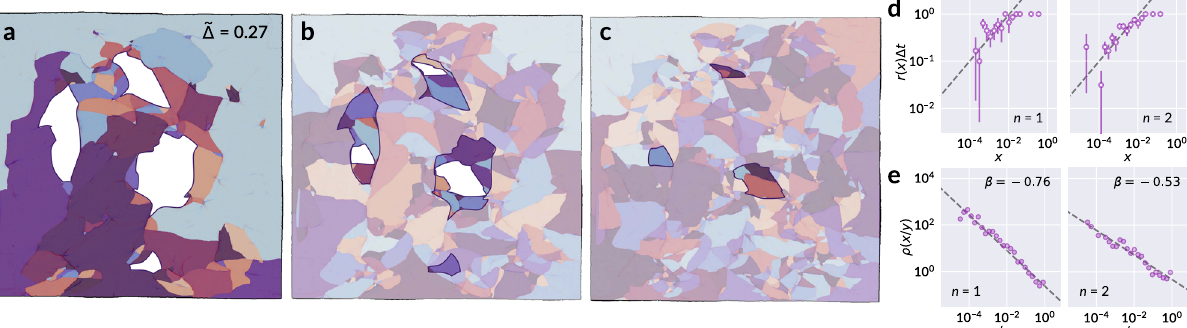
Fig. 2 Estimation of breakup rates. a Segmentation of a sample sheet crumpled once at compaction ~ Δ ¼ 0 : 27, with four selected facets outlined and emphasized in white. Shown in b are the new facets that subdivide those regions after crumpling a second time ( n = 2). In c , the subdivision of the facets highlighted in b is shown after n = 3. d For n = 1 (left), the proportion of facets r ( x ) Δ t present in a as a function of their area x , which have fragmented into at least two distinct facets in b over the elapsed Δ t between n = 1 and n = 2. For n = 2 (right), the fraction of facets from b which have fragmented in c . Error bars denote the standard deviation of the fragmentation probability if the fragmentation of each facet is regarded as a Bernoulli trial, with the fraction of fragmented facets taken as the success probability within each histogram bin. The dashed line corresponds to function ρ ( x / y ) of facet areas x normalized by their parent facet ’ s area y from the previous crumpling iteration. The n = 1 (left) panel is the distribution of area fractions for facets in b relative to their parent facets in a , and n = 2 the corresponding distribution for facets in c relative to b . The dashed line corresponds to a fi t of Eq. (3) with the fi tted exponent β